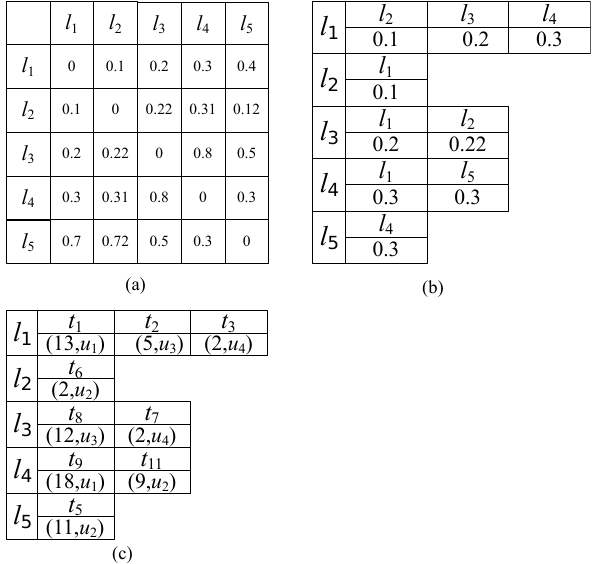
Figure 2. Distance matrix and location D-index and T-index: ( a ) the distance matrix between locations, with the distance unit being km ; ( b ) the index of distance between candidate location and others; ( c ) the index of the optional adding time for each candidate dummy check-in